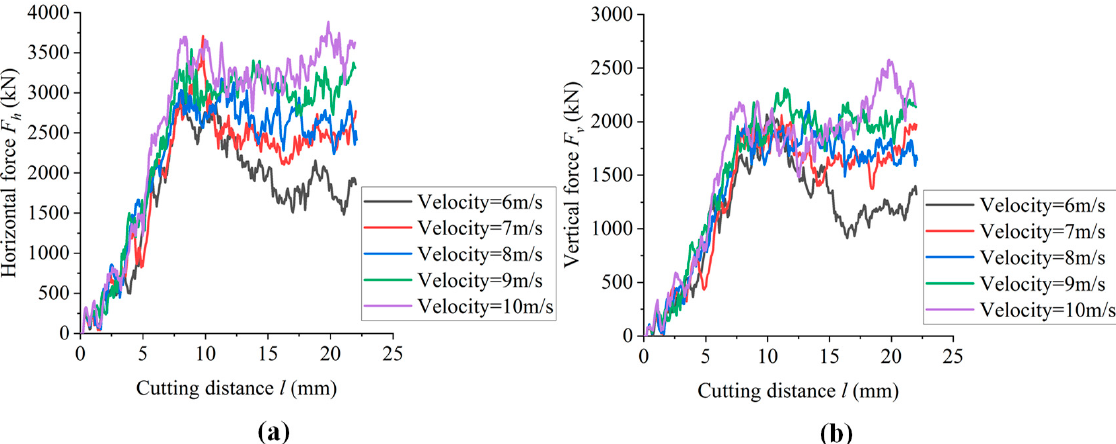
Figure 19. Cutting force vs. cutting distance curves at different cutting rates. ( a ) Horizontal compo- nent vs. cutting distance; ( b ) vertical component vs. cutting distance.